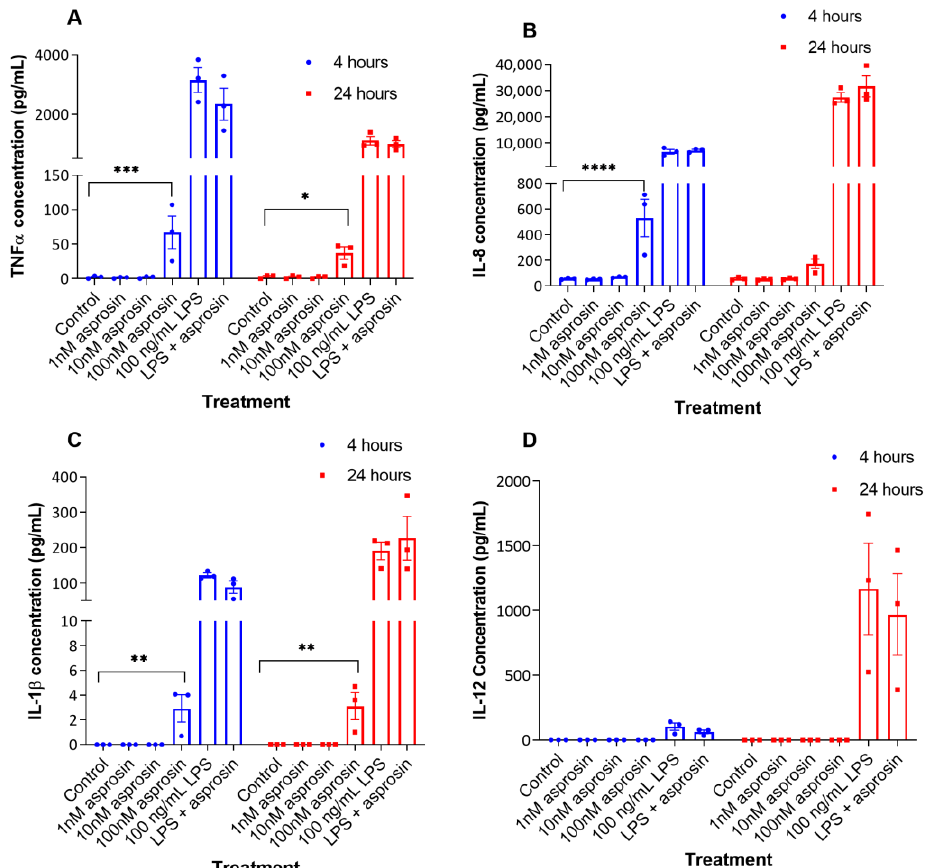
Figure 2. Asprosin treatment (100 nM) increases the release of tumour necrosis factor α (TNF α ), interleukin-8 (IL-8) and IL-1 β by THP-1 macrophages. THP-1 macrophages were treated with increasing concentrations of asprosin (1 nM, 10 nM, and 100 nM), 100 ng/mL lipopolysaccharide (LPS) or both 100 ng/mL and 100 nM asprosin for 4 h and 24 h. Cell supernatants were collected and ( A ) TNF α , ( B ) IL-8, ( C ) IL-1 β , and ( D ) IL-12 β concentrations were measured by ELISA. Data were analysed by two-way ANOVA and Tukey’s multiple comparisons test (compared to respective controls). Data are presented as mean ± SEM; n = 3; * p < 0.05; ** p < 0.01; *** p < 0.001; **** p < 0.0001.